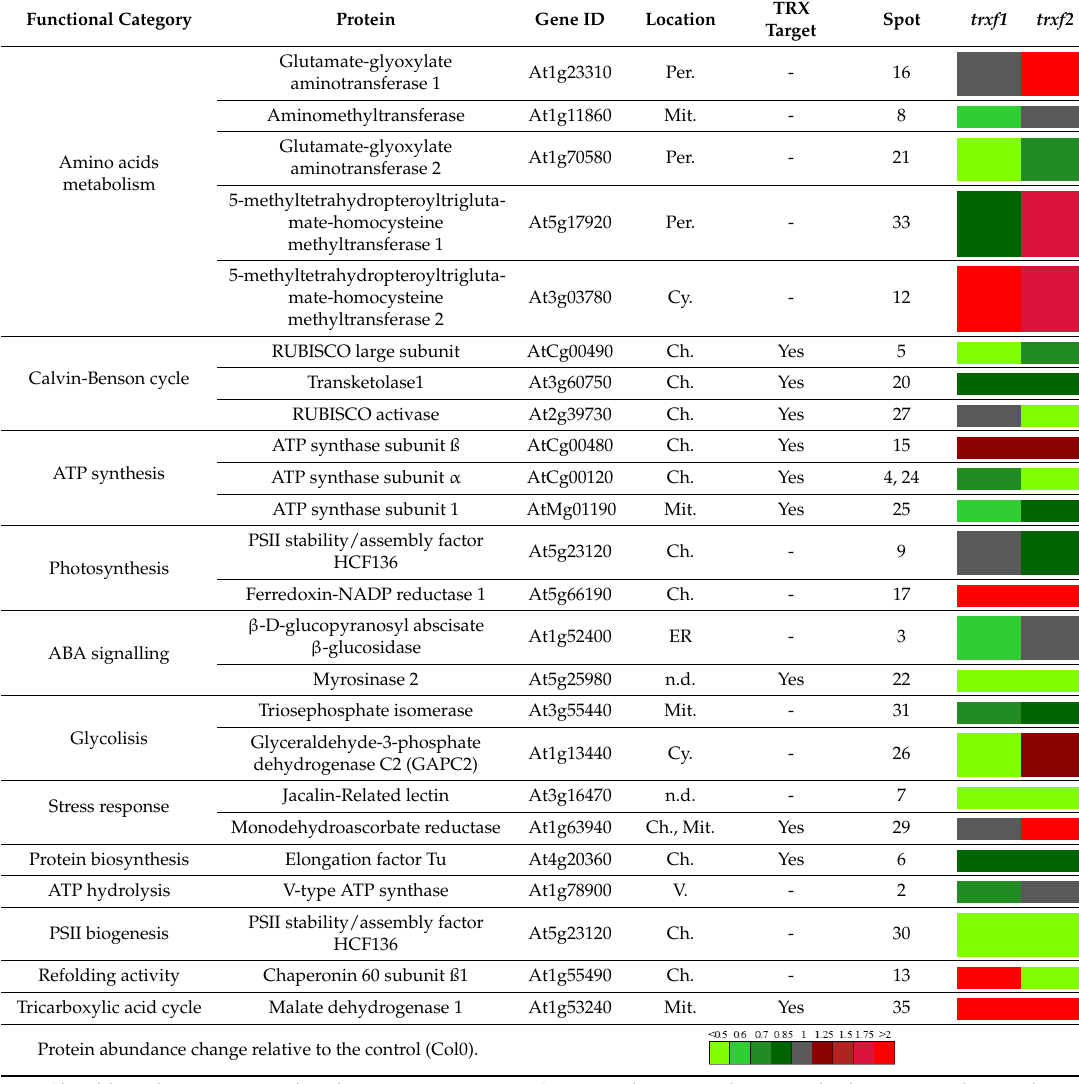
Table 1. Differentially expressed proteins identified by MS in the trxf1 and trxf2 mutants, organized inthe functional category, the gene code and the subcellular localization and whether the protein has been reported as a Thioredoxins (TRX) target. The color code indicates fold change in protein abundance.